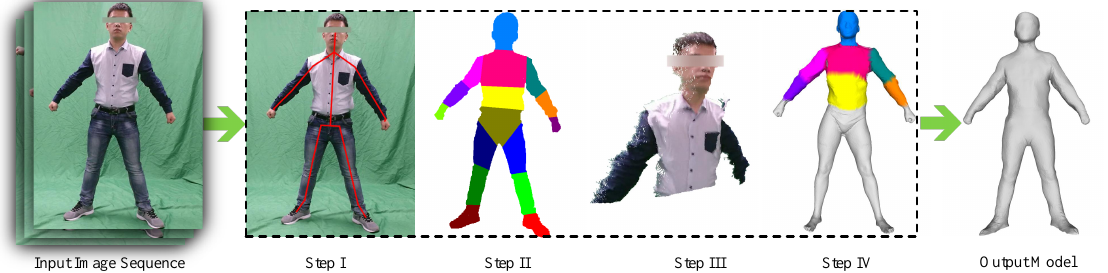
Figure 2. Our system’s pipeline begins by taking an image sequence as input, and its output is the reconstructed human model.